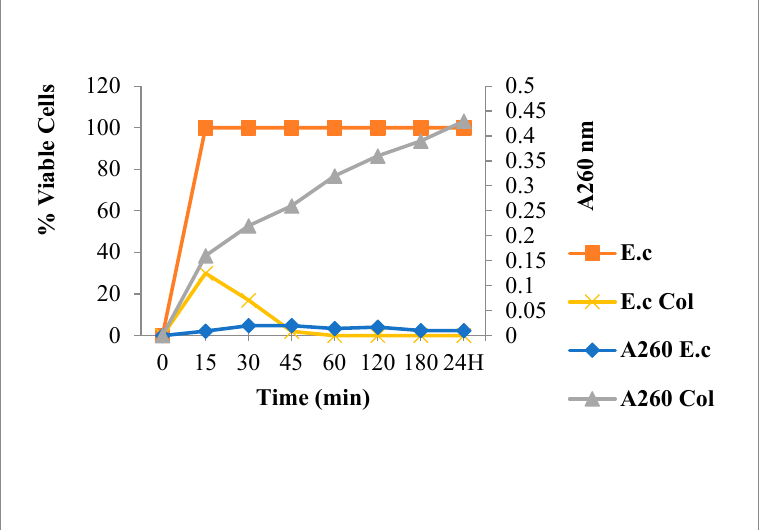
Figure 7. 260 nm absorbent material release and E. coli viability following Colistin ( Col ) treatment.